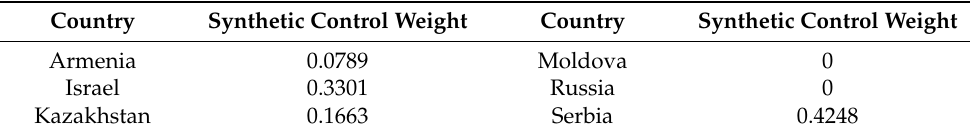
Table 3. Synthetic weights for the EU-8—sensitivity analysis 1.